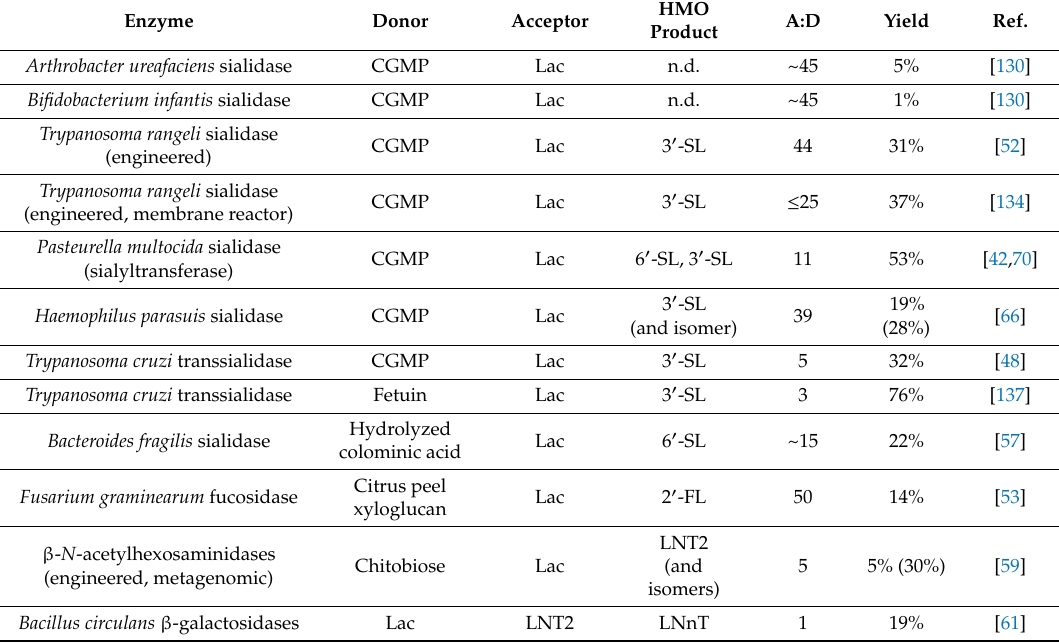
Table1. SynthesisoftrueHMOstructureswhereabundantlyavailablenaturalsubstrates—orderivatives of these—have been employed. Yields are given as molar yield based on the donor substrate (for casein glycomacropeptide (CGMP), all available Sia moieties are considered, although not all are present with a linkage accepted by the enzymes; see the main text). Abbreviations: A:D: molar